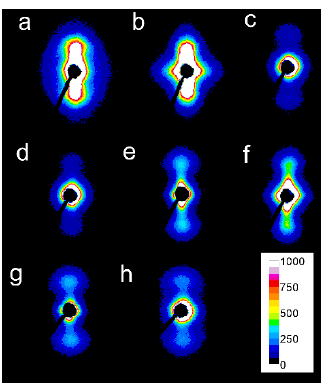
Figure 8. 2D-SAXS patterns of PLLAs: L339 sheared at 170 °C at 5 /s for 20 s ( a ) and at 20 /s for 5 s ( b ) and cooled at 10 °C/min, 4S123 sheared at 150 °C at 10 /s for 10 s ( c ) and at 20 /s for 5 s ( d ) cooled at 30 °C/min, L240 sheared at 150 °C at 10 /s for 10 s ( e ) and at 20 /s for 5 s ( f ) cooled at 30 °C/min, 6S245 sheared at 150 °C at 10 /s for 10 s ( g ) and at 20 /s for 5 s ( h ) cooled at 30 °C/min. Shearing direction - vertical.